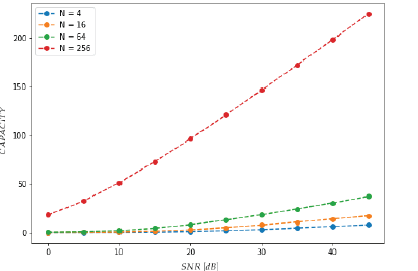
Figure 9. CSK constellation for N = 2 2 i × 2 2 i , i = 1.